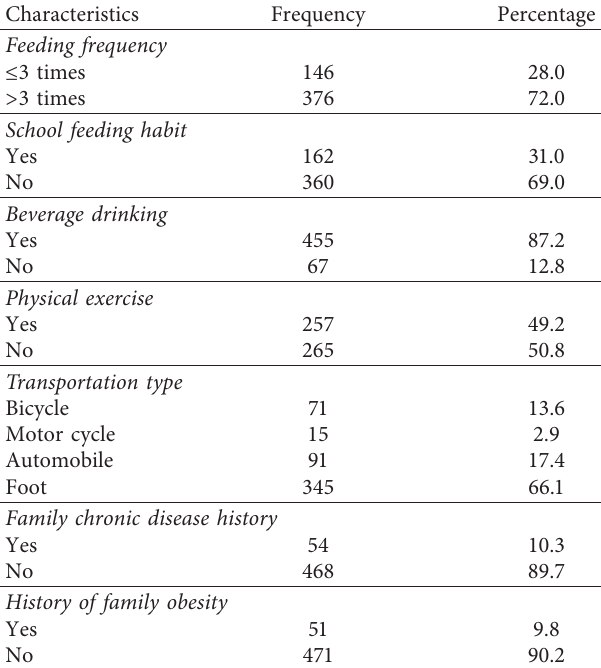
Table 2: Dietary, lifestyle, and parent history-related characteristics of high school adolescents at Bahir Dar city, northwest Ethiopia ( n �